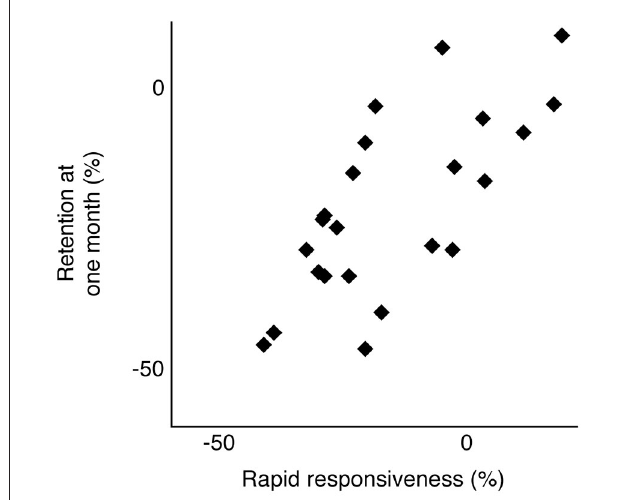
FIGURE 4 | Skill retention at 1 month is plotted as a function of rapid responsiveness across all participants available for follow-up . Both values are expressed as a percentage of trial 1 performance (Eqs. 1 and 3), with more negative values indicating more improvement relative to trial 1. Spearman’s rank correlation coefficient, ρ = 0.66; p =